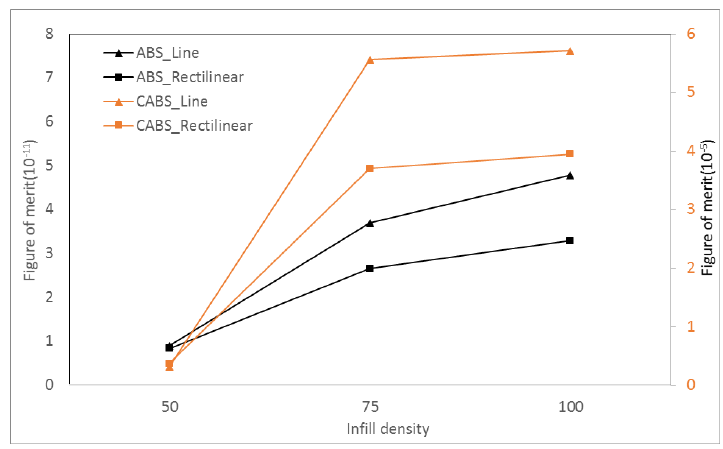
Figure 13. Figure of merit of ABS and CABS composites with different infill density and printing pattern.